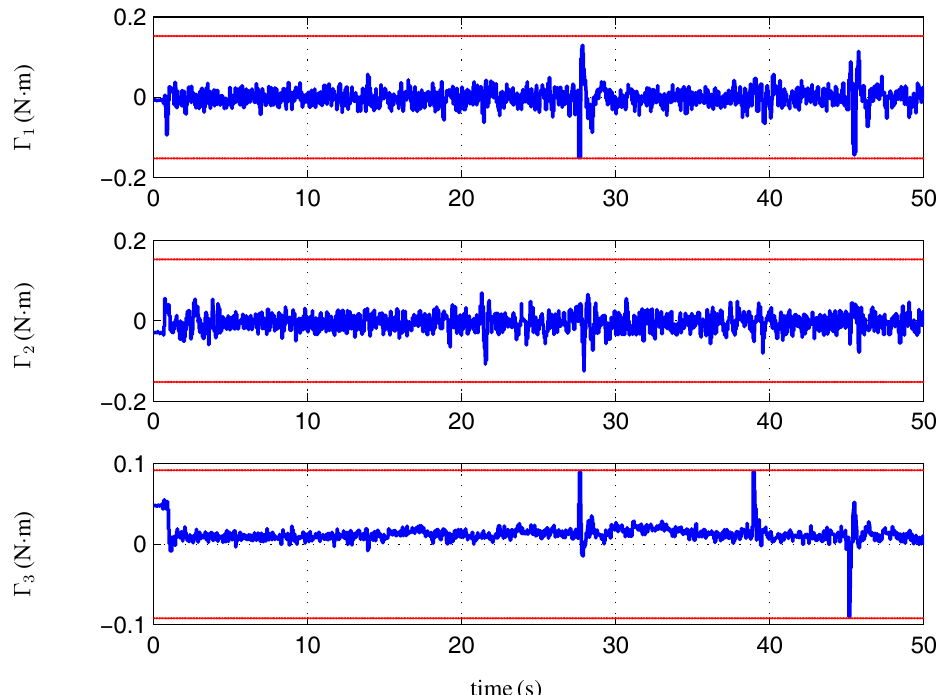
Figure 16. The bounded control torques of Corollary 2. The red dashed lines define the bounds of the control torques.